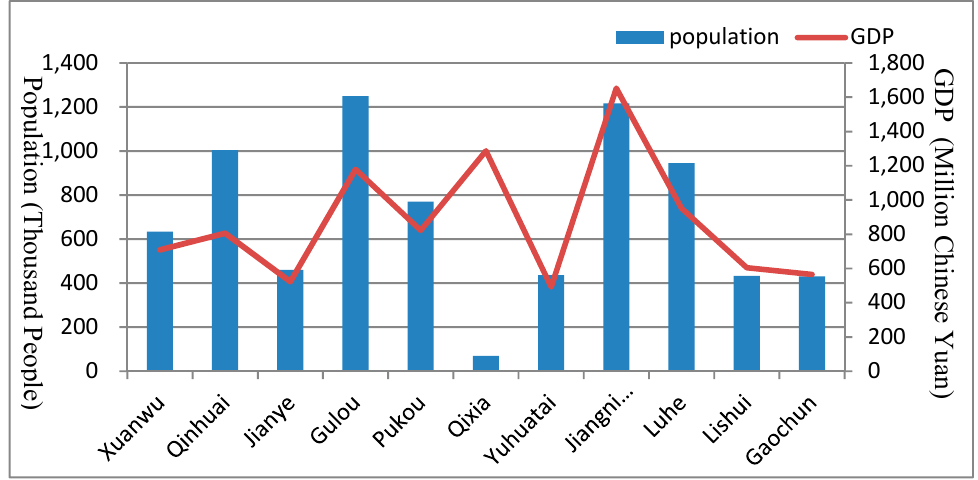
Figure 5. Population and total GDP.